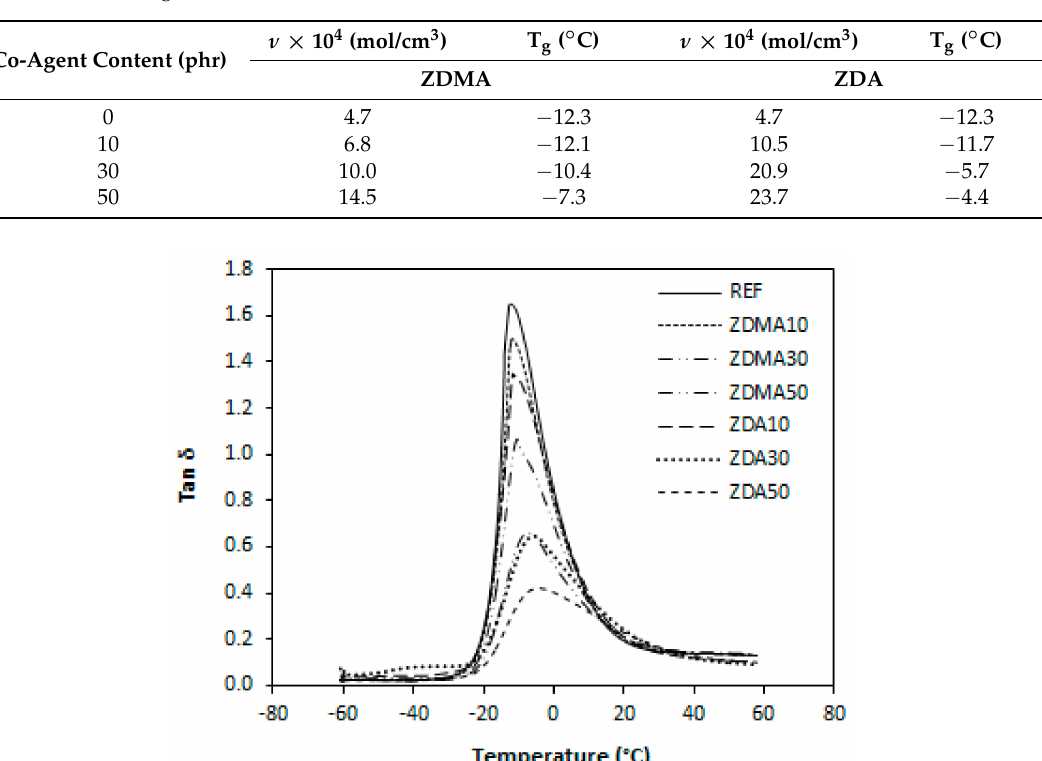
Table 4. Dependences of glass transition temperature T g and cross-link density ν of composites on the amount of co-agents.